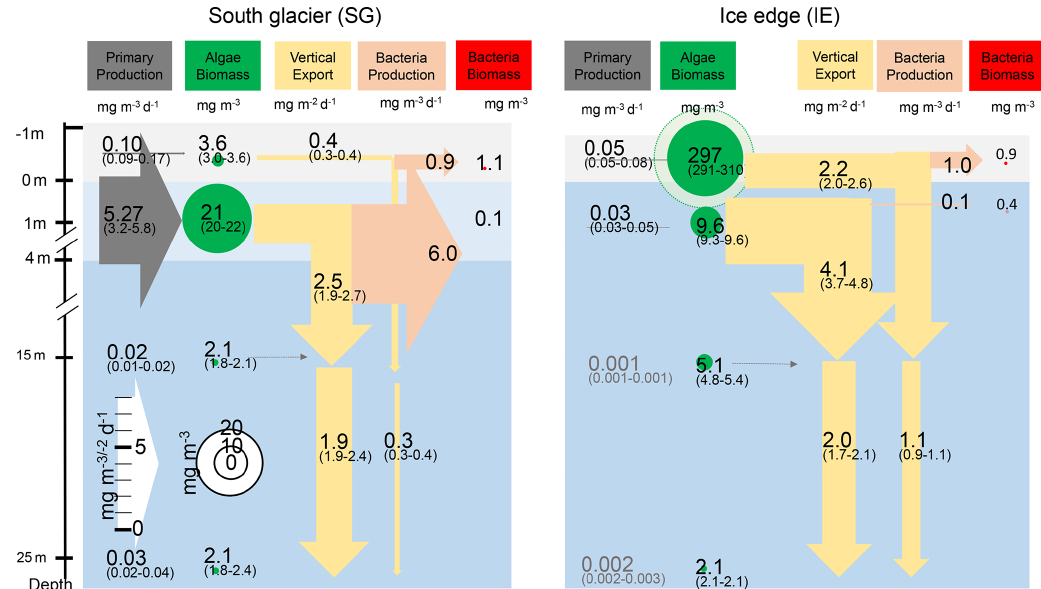
Figure 6. Schematic representation of the C cycle at SG and IE stations. All units are in milligrams of C with the median given in the circles and arrows and the minimum and maximum in brackets below. Depth of 0m is at the sea ice–water interface. Grey arrows indicate net primary production with its height scaled to the uptake rates. Green circles show standing-stock algae biomass converted from Chl to C (conversion factor is 30gC per gram of Chl; Cloern et al., 1995) with its diameter scaled to the concentrations, except sea ice at IE with the light green circle scaled 1 order of magnitude higher. Yellow arrows indicate vertical export of chlorophyll converted to C (conversion factor is 30gC per gram of Chl; Cloern et al., 1995) with the contribution of sea ice algae and phytoplankton estimated by the fraction of typical sea ice algae in phytoplankton net hauls and the width of the arrows scaled to the fluxes. Orange arrows indicate bacterial biomass production based on dark carbon fixation (conversion factor is 129gC per gram of DIC; Molari et al., 2013) with the arrows scaled to the values. Red circles to the right are bacteria biomass assuming 20fgC per cell in the bottom sea ice and UIW. The grey area represents sea ice, the light blue area a brackish water layer, and the darker blue area deeper saline water